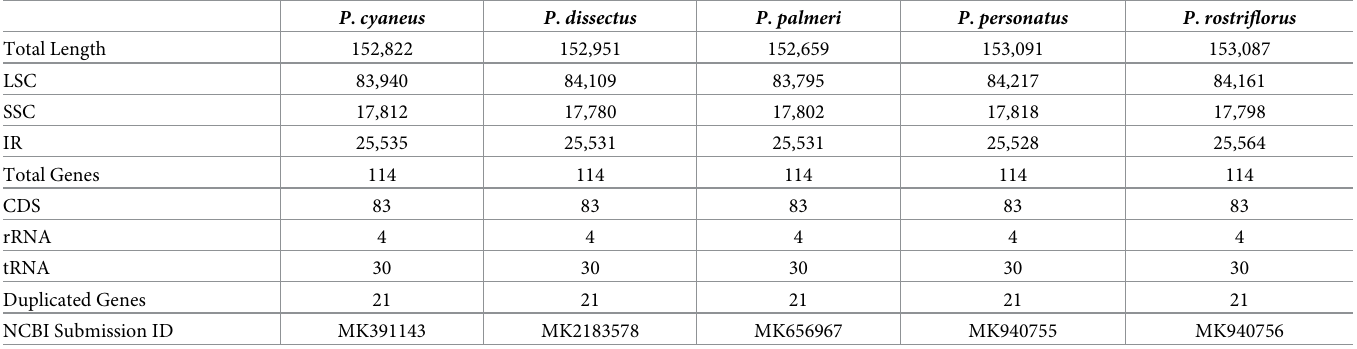
Table 3. Plastome sequence assembly results. Total sizes of the Penstemon plastome, long single copy (LSC), short single copy (SSC), and inverted repeat (IR) for each species, as well as the counts of total genes, coding DNA sequence (CDS), rRNA, tRNA, and duplicated genes (within IR regions), followed by the NCBI sequence and annotation submission ID number.